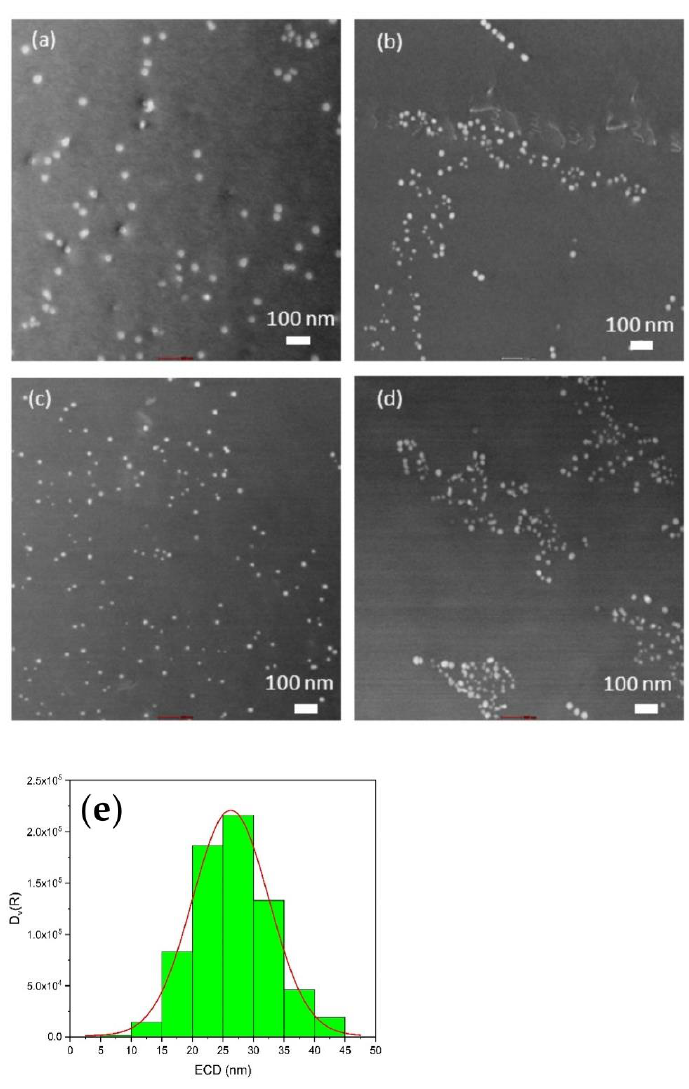
Figure 5. Dark field HAADF-STEM image of Zr-containing dispersoids in samples ( a ) #1, ( b ) #7, ( c ) #10, and ( d ) #17, and ( e ) size distribution of dispersoids derived from TEM.